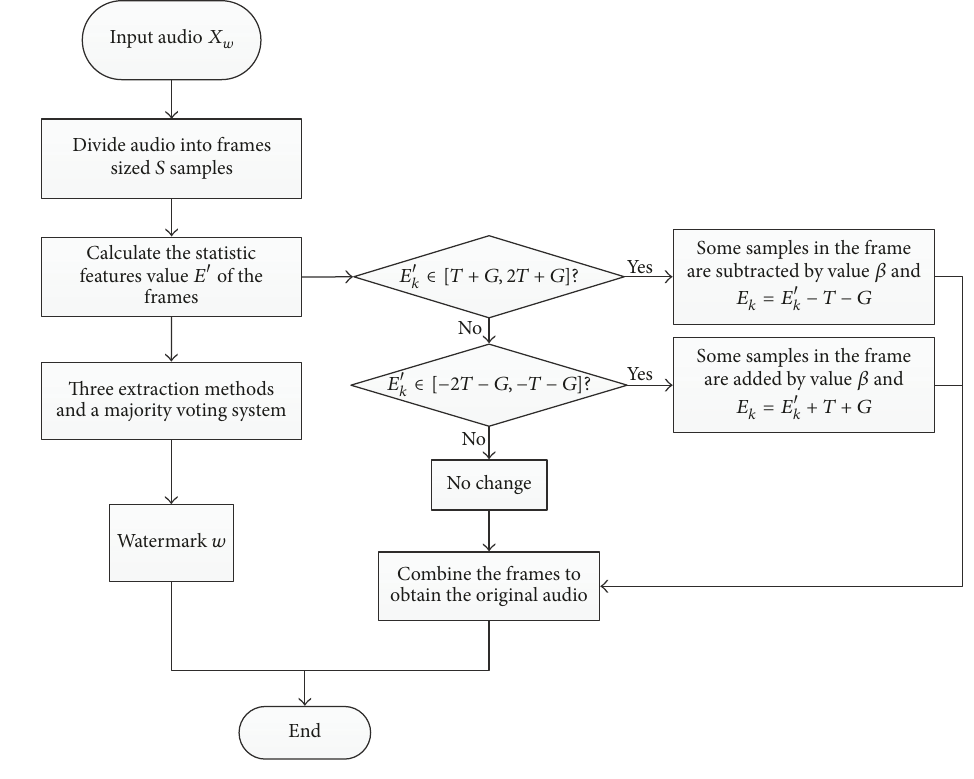
Figure 6: Watermark extracting process.